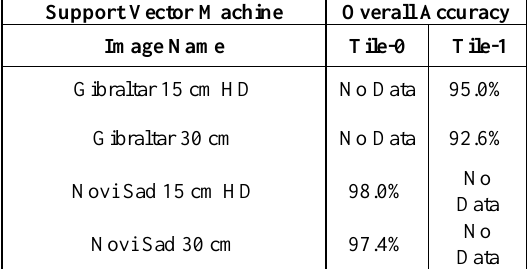
Table 4. The overall accuracy values obtained from the SVM model results for all tiles in both